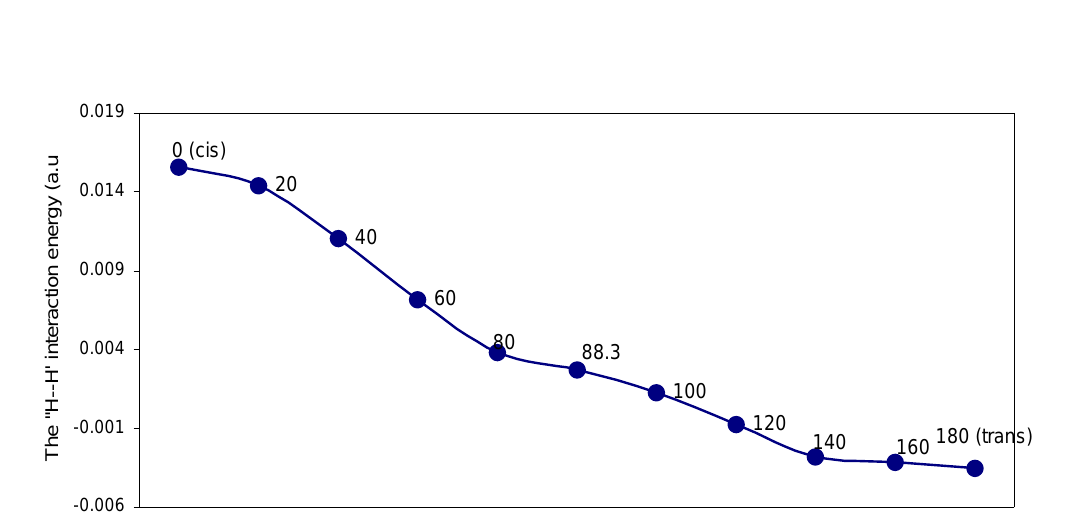
Figure 5. Plot of 'H---H' nonbonding interaction energy as a function of torsional angles in Hydrogen